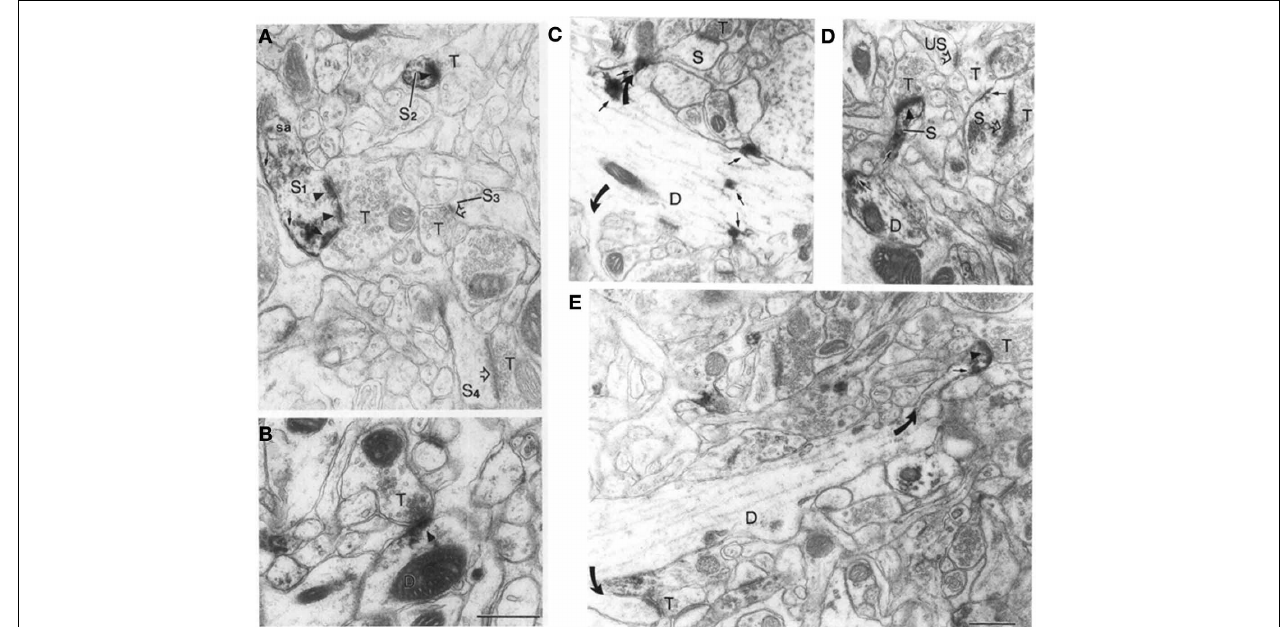
FIGURE 3 | NOS1 positive spines at the EM level in the Visual Cortex. (A) Large dendritic spine (S1) with a perforated PSD showing NOS1-immunoreactivity (arrowheads). NOS1 immunoreactivity is also present along the plasma membrane (small arrow) and near the spine apparatus (sa). A second small spine (S2) shows NOS1 immunoreactivity along the plasma membrane and over the PSD. Not all spines are labeled (S3 and S4). T represents unlabeled pre-synaptic terminals. Open arrows mark unlabeled PSDs. (B) Axodendritic synapse showing NOS1 labeling of a PSD (arrowhead). (C) NOS1 labeling occurs at the spine base (upper curved arrow) and dendritic